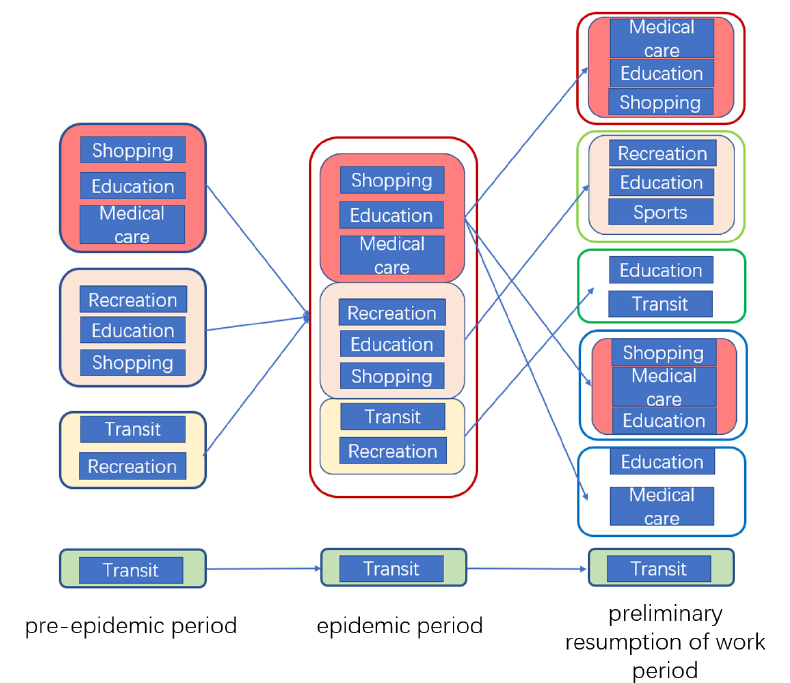
Figure 14. Shifting traffic flow patterns in urban hotspots at different stages.